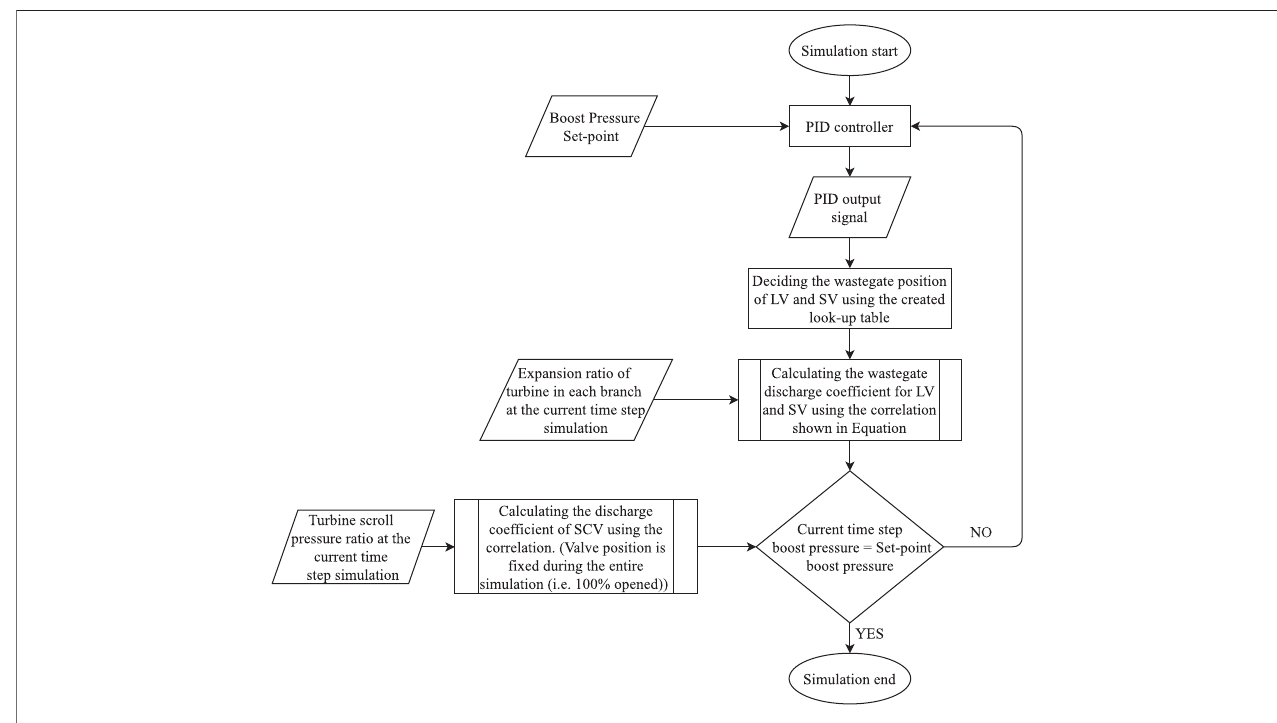
FIGURE 8 | Working of the designed control system when the wastegate fl ow area is same and the SCV valve is opened.